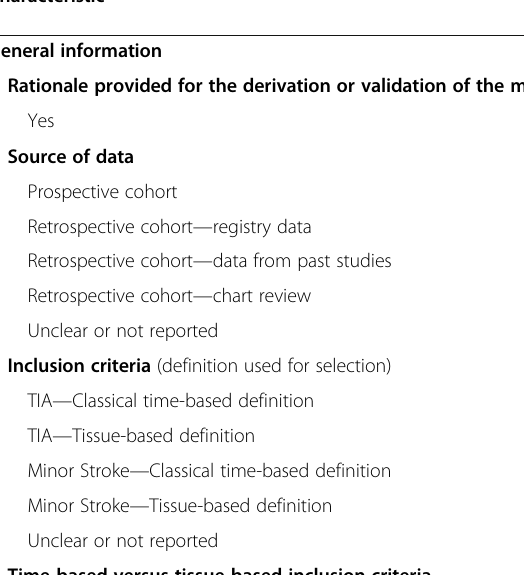
Table 2 Reporting of essential items applicable to both derivation and validation studies